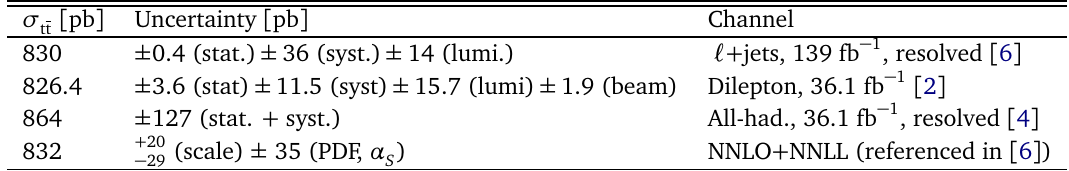
Table 1: Comparison between the tt inclusive cross-section measurements discussed here, as well as the prediction from NNLO + NNLL